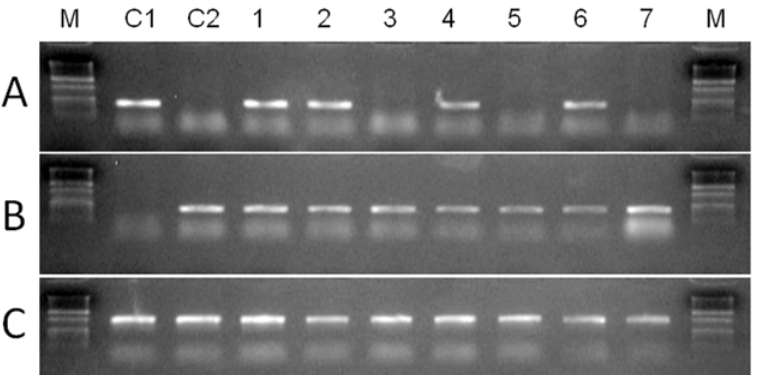
Figure 2. PCR analysis of sperm from 7 recipients eight months after the germ cell transplantation. The primers used were an O. bonariensis -specific sequence (A), an O. hatcheri -specific sequence (B) and b -actin (C) as a template control. Control lanes include a pure O. bonariensis (C1) and an O. hatcheri (C2). Donor-derived ( O. bonariensis ) spermatozoa were detected in the sperm of four recipients shown in lanes 1, 2, 4 and 6.